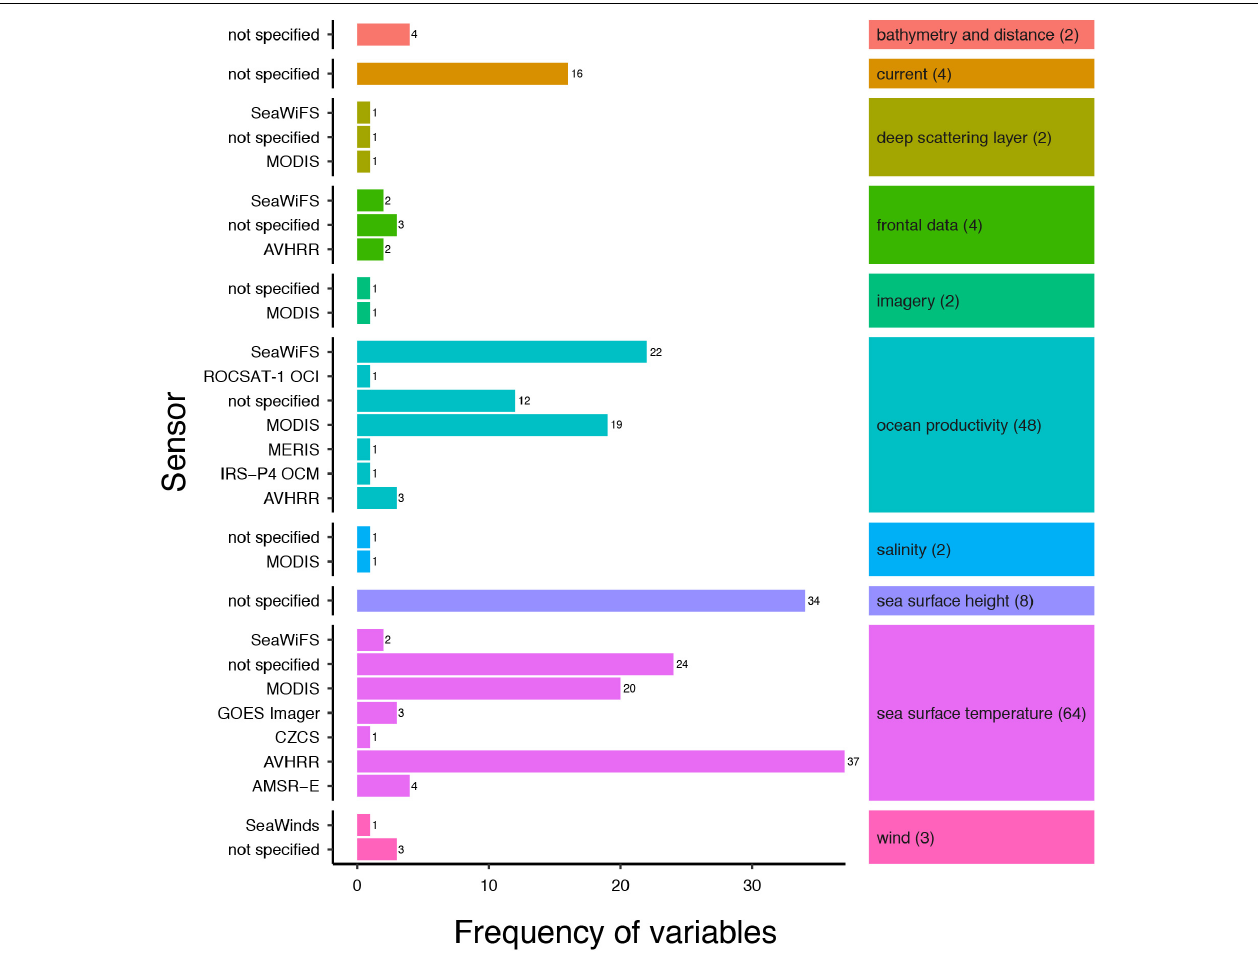
FIGURE 2 | Frequency of SRS variables split by the sensor used to obtain the variable. Multiple metrics of an SRS variable were counted (see Table 1 ). Number of articles using a specific variable are in parentheses. A list of sensor acronyms can be found in Supplementary Table S3 .